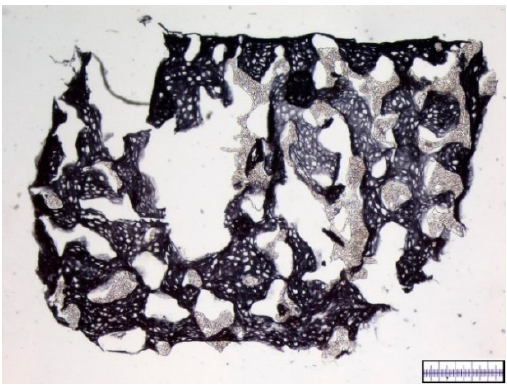
Figure 8. Representative slide of an Actifit ® scaffold after 21 days of in vitro chondrogenesis. Collagen type I immunohistochemistry. Collagen type I-rich areas appear black. Magnification bar = 500 µ m.